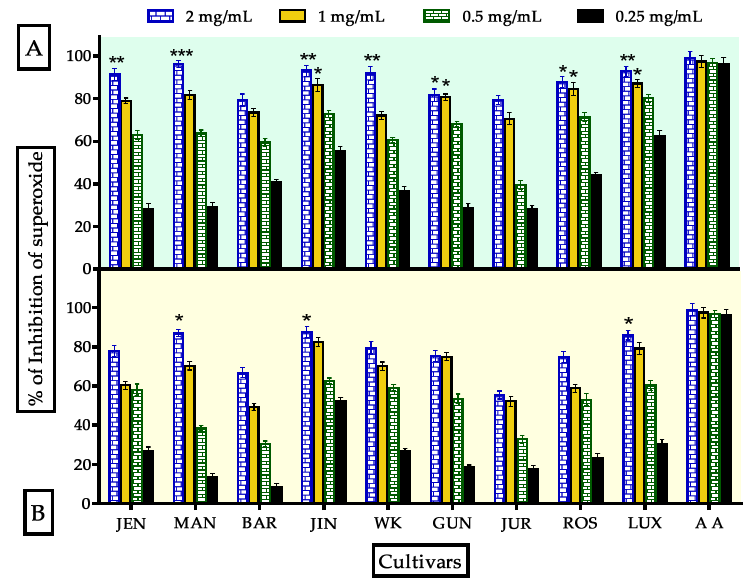
Figure 4. Antioxidant activity of unprocessed and processed lupin flours assayed by superoxide scavenging method; nine cultivars vs. ascorbic acid (standard). ( A , B ) indicated superoxide radical scavenging activity correspondingly. Data were stated as mean ± SEM where n = 3 (*** Significance at p < 0.001, ** significance at p < 0.01 and * significance at p < 0.05 vs. standard: ascorbic acid). Table 3. IC 50 values of highly active cultivars in different types of in-vitro antioxidant test. IC 50 values